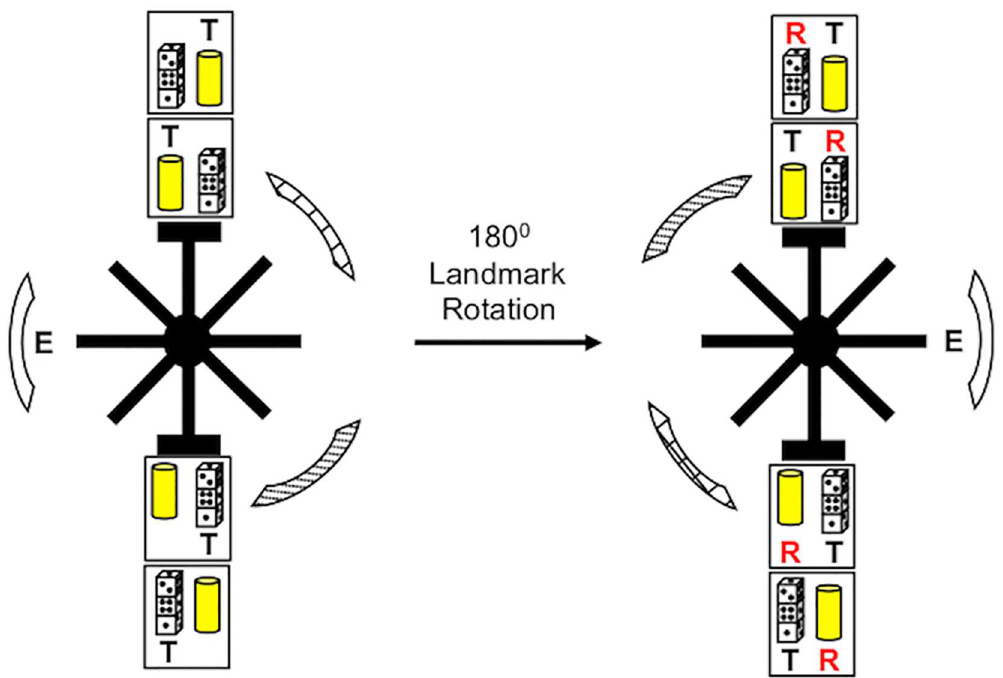
Fig 1. Floor plan with arrangement of room cues, objects, and maze position. Three distal landmarks and experimenter ( E ) position is shown during training (left panel) and probe tests (right panel). T indicatesthe reinforced object-place paired associate during training. R indicates the opposite,or reversal, object. If distal cues control choice behaviorin the object-place task, then the reversal object will be the preferred choice following180˚ rotation of the distal landmarks during the probe